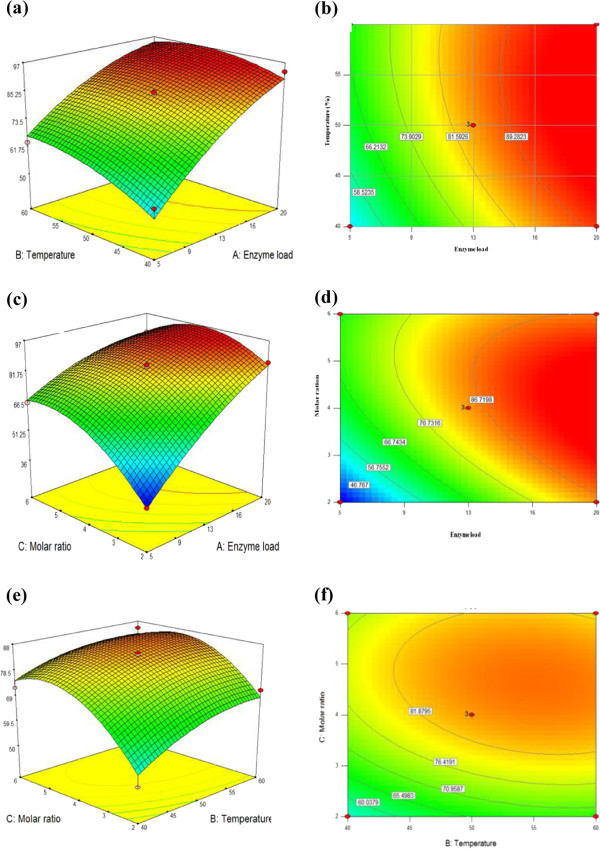
Response surface and 3D contour plots indicating the effect of interaction between reaction parameters on D- isoascorbyl palmitate conversion rate (a, b) interaction between enzyme load and temperature while holding molar ratio at 4 (c, d) interaction between enzyme load and molar ratio while holding temperature of 50°C (e, f) interaction between temperature and molar ratio while holding enzyme load at 13% (w/w).